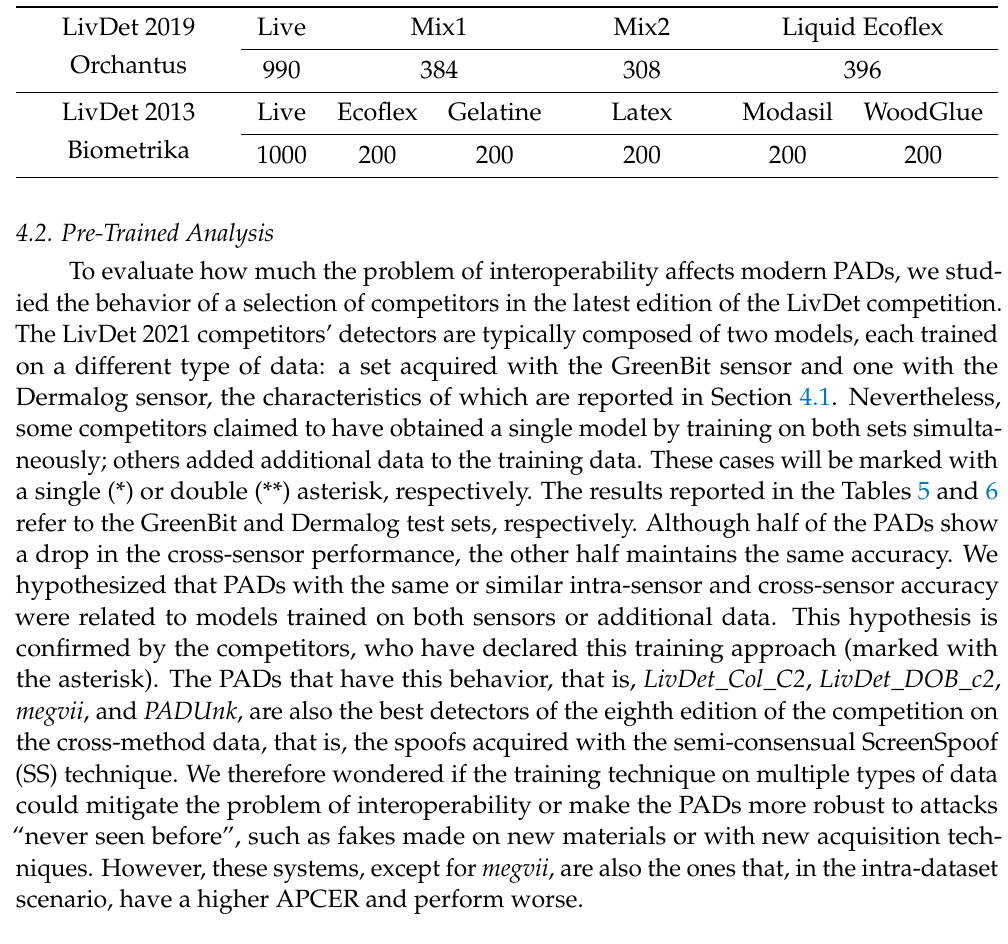
Table 5. Results of LivDet 2021 competitors on test sets acquired with the GreenBit sensor. In particular, GB CC is a test set acquired with the consensual technique, while GB SS is a test set acquired with the ScreenSpoof technique. (*) indicates training on both GreenBit and Dermalog Livdet training sets. (**) indicates training on additional data with respect to LivDet training